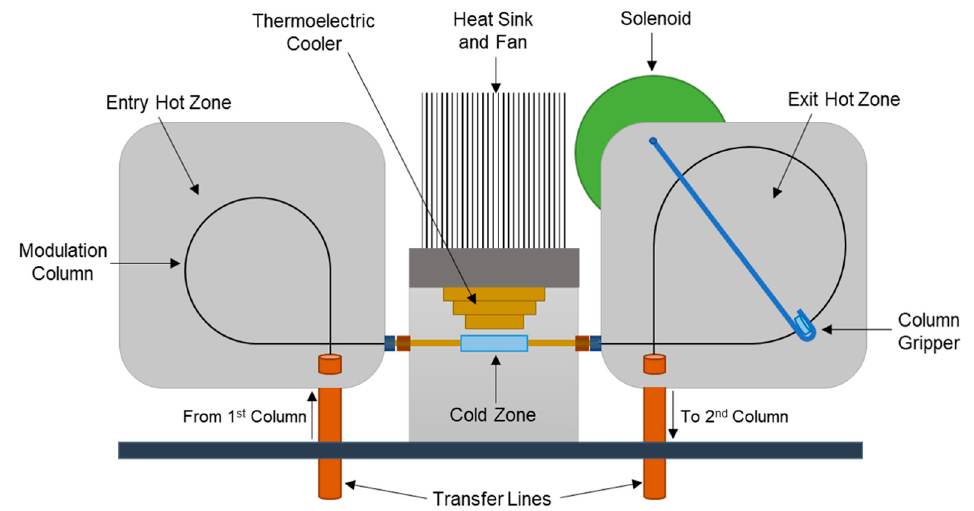
Figure 1. Schematic of the solid-state modulator, based on Reference [13].